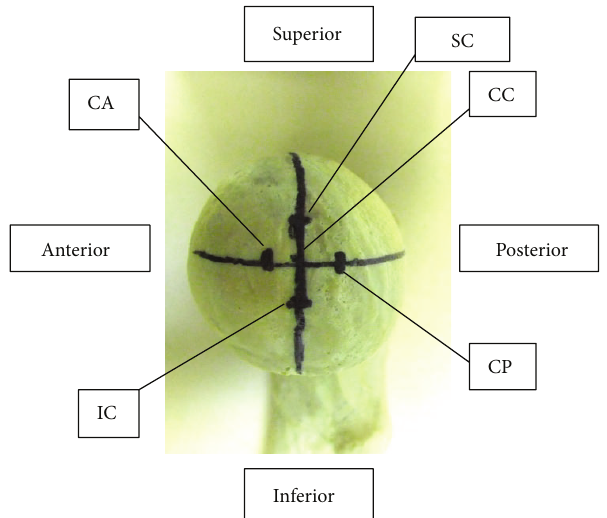
Figure 1: Different implants positions. 4 exit points were 8mm away from the head center. (CC) AP view-center, lateral view-center, (SC) AP view-superior, lateral view-center, (CP) AP view-center, lateral view-posterior, (CA) AP view-center, lateral view-anterior, (IC) AP view-inferior, and lateral